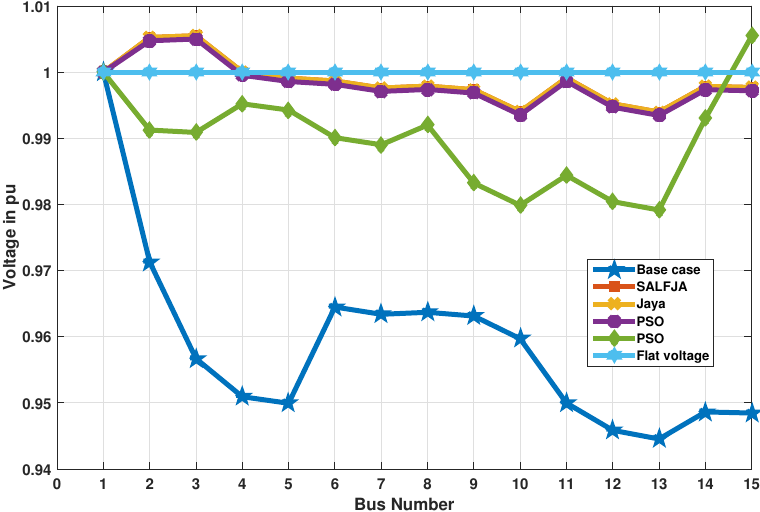
leads to enhanced power quality operation of the distribution system.